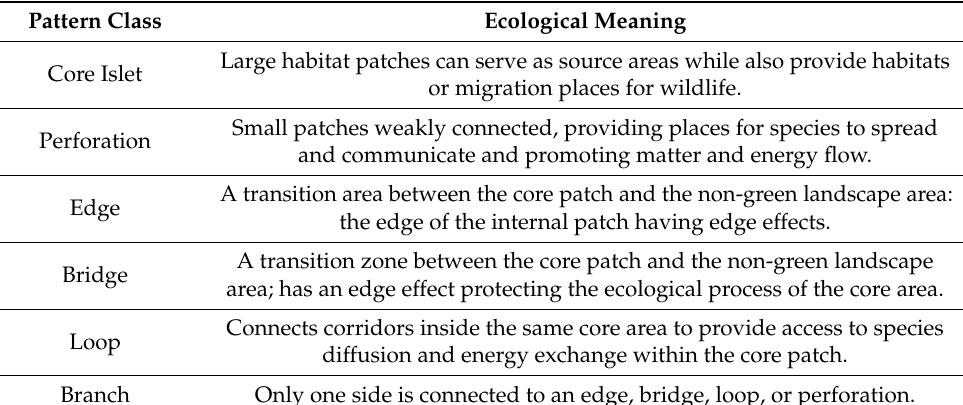
Table 2. MSPA pattern classes definition